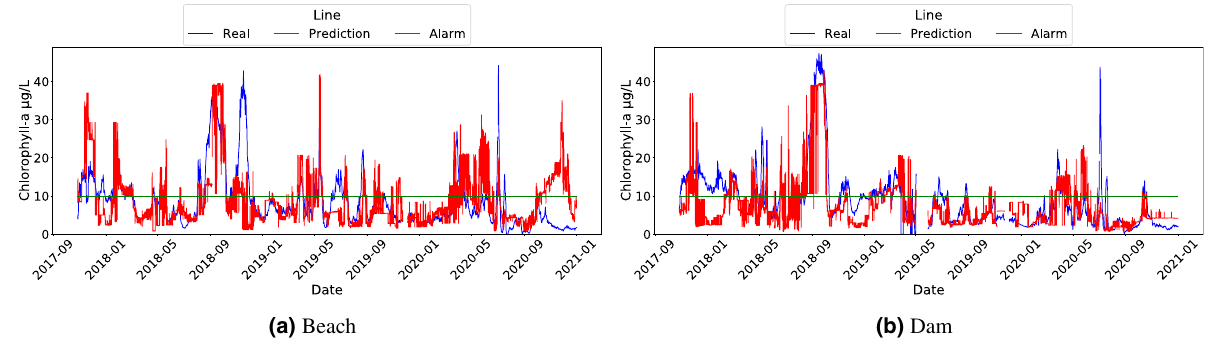
Figure 7. Line plots of Chl- a and RF predictions (time is shown in x-axis and the Chl- a value in y-axis) using the median of Chl- a computed over a day (output_day_median) as output for Beach ( a ) and Dam ( b )